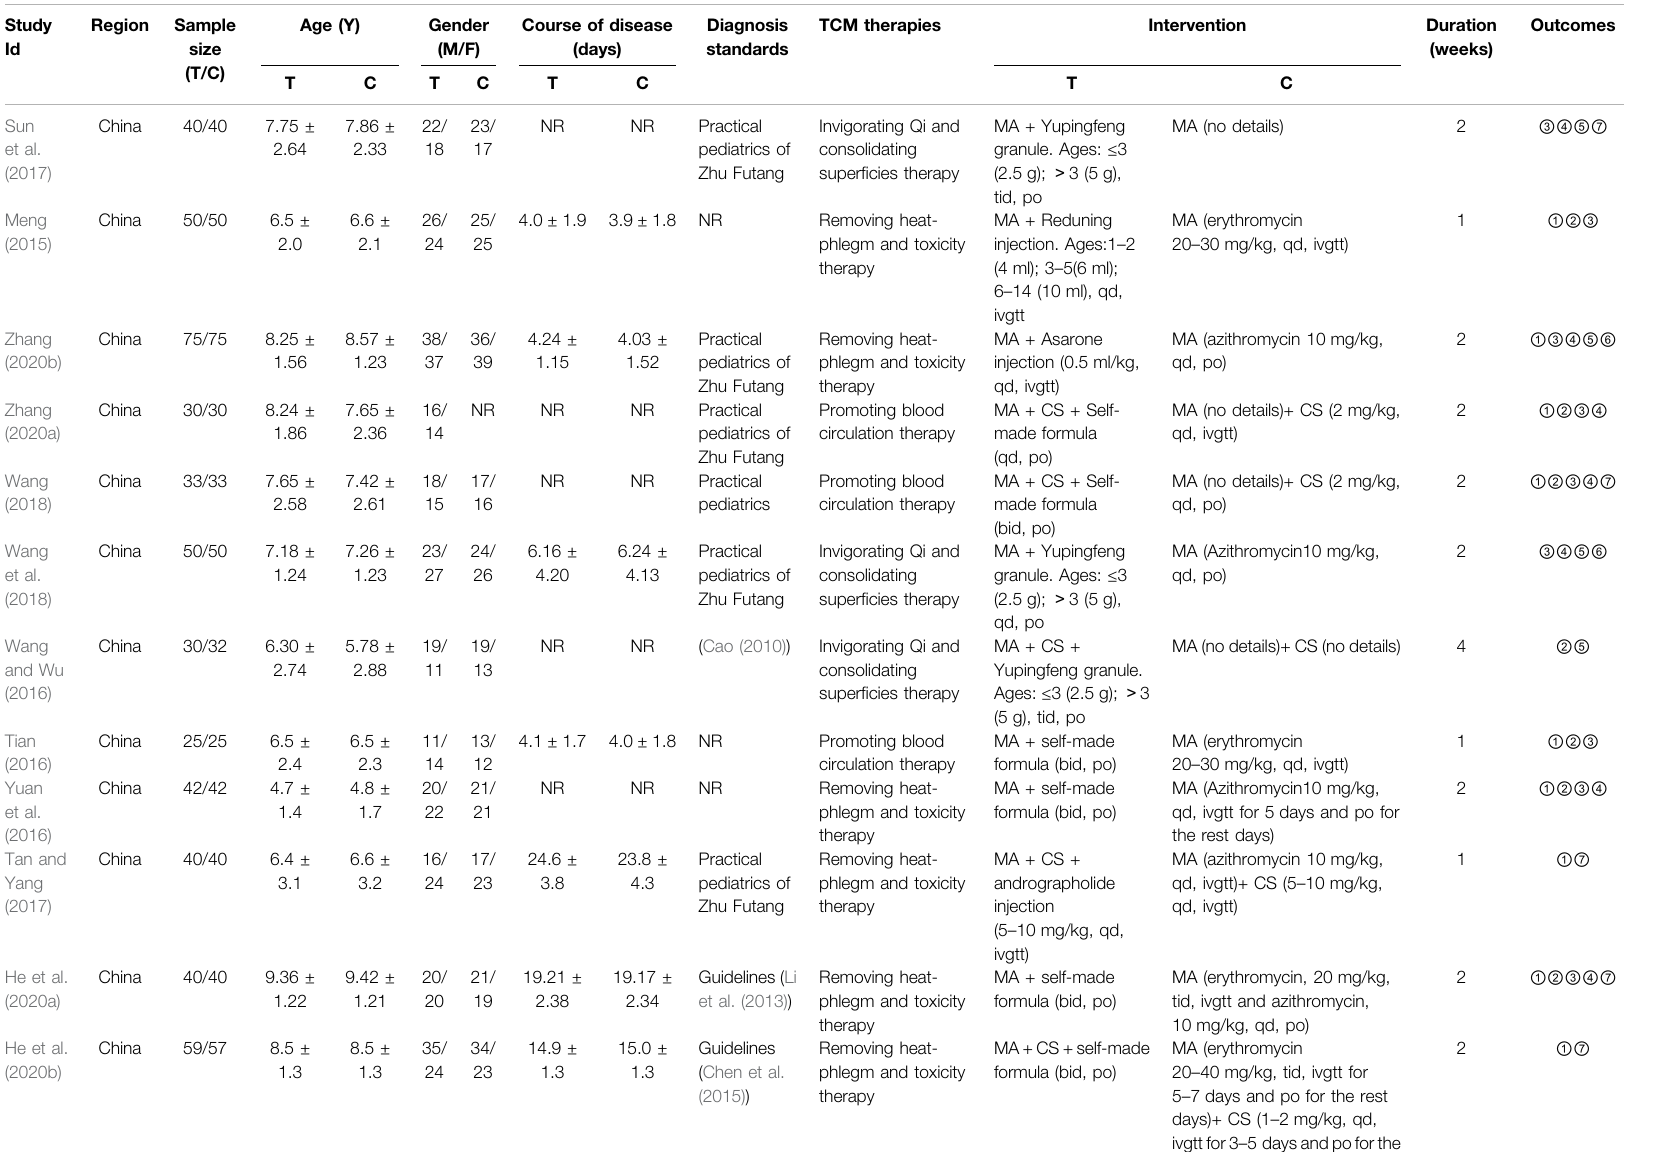
TABLE 1 | Baseline characteristics of included